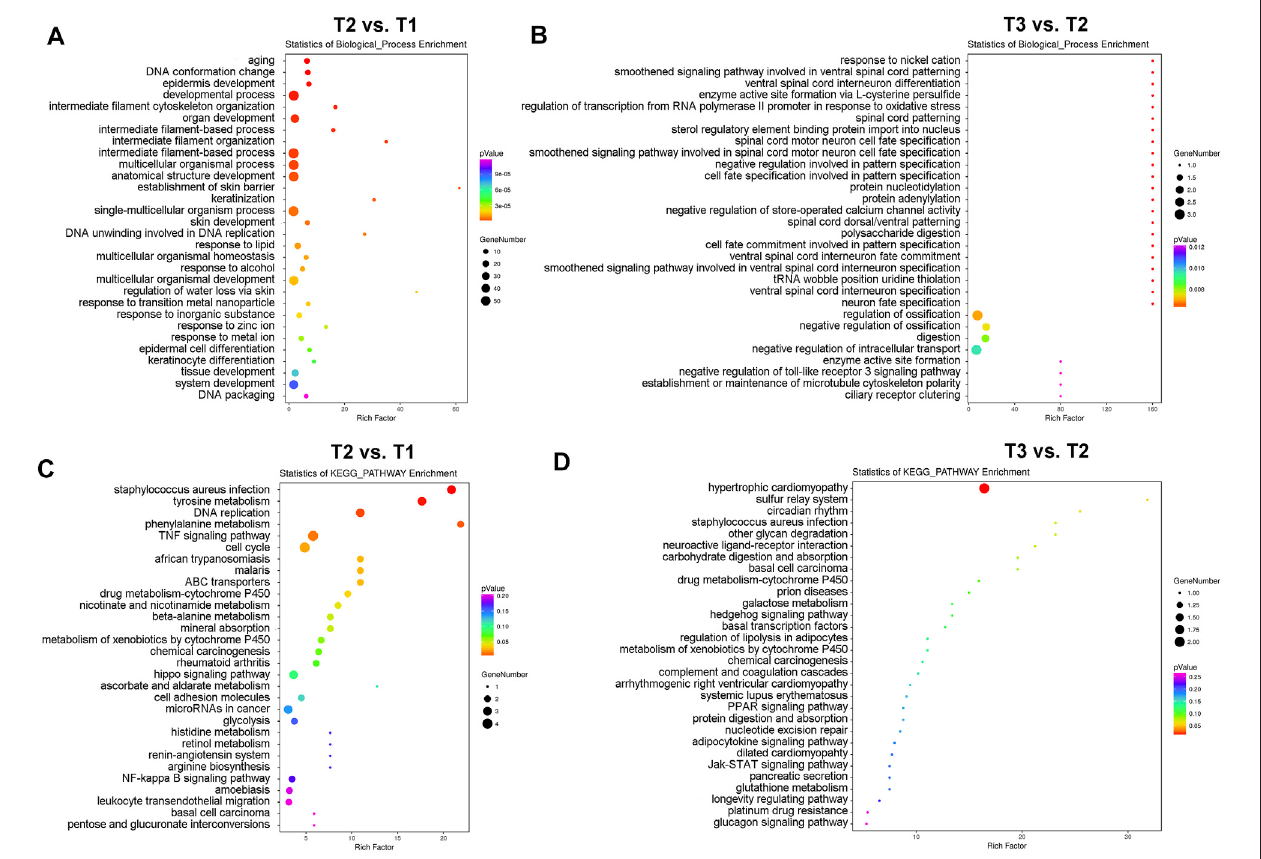
FIGURE2| GOandKEGGpathwayenrichmentanalysesofDEPs.DEPswithfoldchange ≥ 1.50or ≤ 0.66and p values < 0.05(T2vs.T1:26up-regulatedDEPsand 83 down-regulated DEPs; T3 vs. T2: 35 up-regulated DEPs and four down-regulated DEPs) are selected for GO (A,B) and KEGG pathway enrichment analyses (C,D) . Cyclic stretch evokes signi fi cant changes in the extracellular matrix organization, cytoskeleton remodeling, multicellular organismal homeostasis, metal ion response, aging, DNA conformation, keratinization, cell differentiation, cell cycle, and cell fate, which are inhibited by GsMTx4.